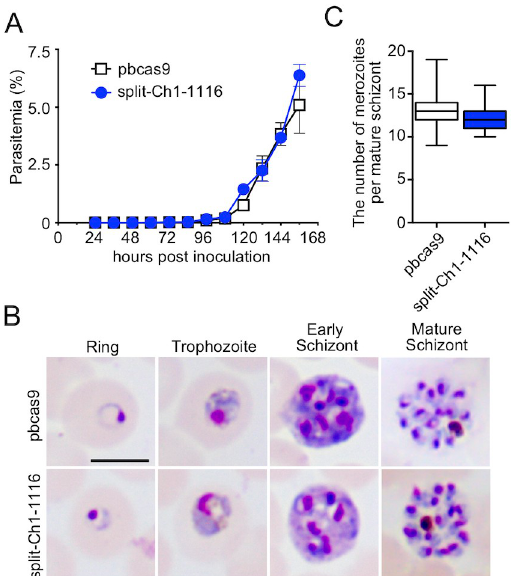
Fig 3. Asexual development of the split-Ch1-1116 parasites. (A) The growth of the split-Ch1-1116 parasites, which is indicated by the blue line, was comparable to that of the parental pbcas9 parasites, which is shown by the black line. The points and error bars represent the mean and standard error of the mean of triplicate values. Distributions for each day were compared using the unpaired t -test (not significant). (B) The morphologies of the parasites during asexual development were similar between pbcas9 (upper) and split-Ch1-1116 (lower). The bar indicates 5 μ m. (C) The number of merozoites per schizonts of the split-Ch1-1116 parasite was comparable to that of the parental pbcas9 strain. The middle line, top, and bottom of the box, top and bottom whiskers are the median, 75th and 25th percentiles, and the maximum and minimum values respectively. Distributions were compared using the unpaired t - test (not